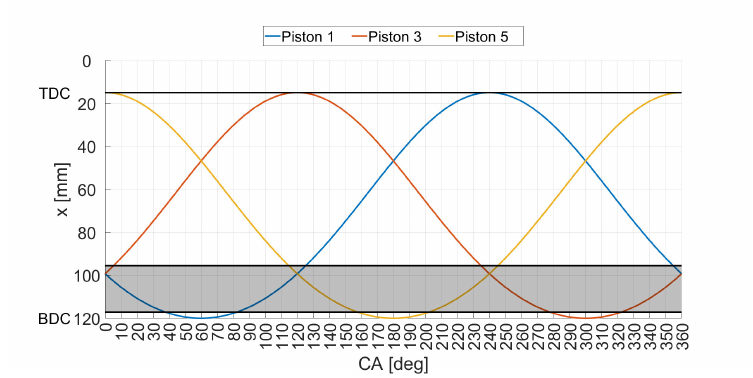
Figure 2. Pistons axial positions as a function of CA.